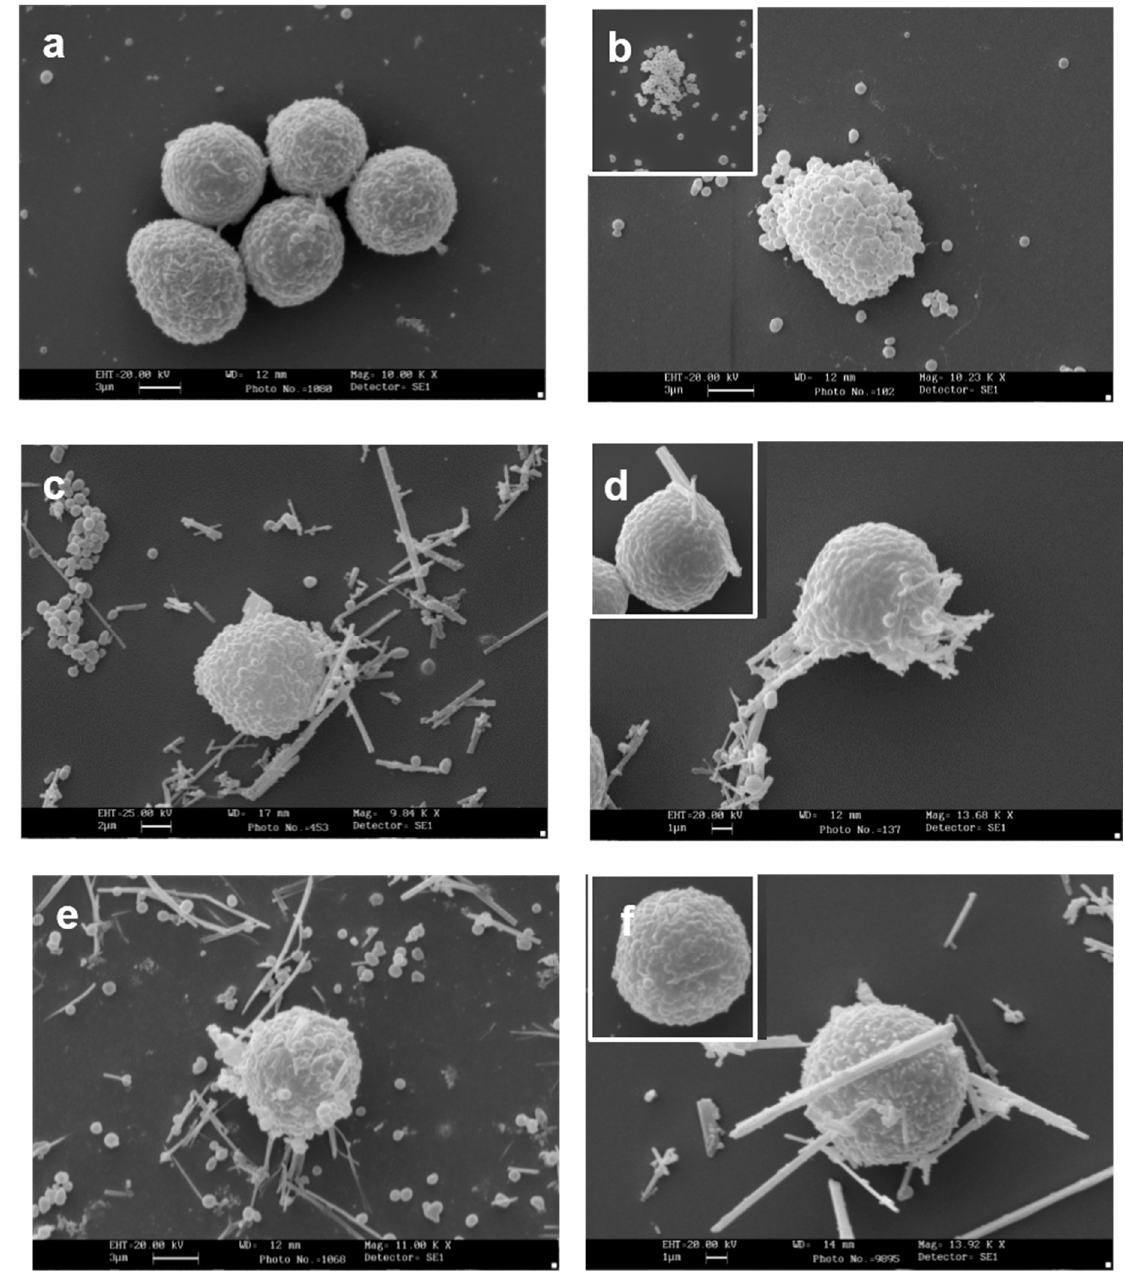
Figure 2. Scanning electron microscope appearance of RPMCs exposed to mineral fibers or stimulated with compound 48/80. ( a ) Unstimulated RPMCs after 30 min of incubation; ( b ) RPMCs exposed to 10 μ g/mL compound 48/80 for 30 min: a large number of granules are secreted and the cell surface shows many protruding granules, while the inset shows an RPMC ghost induced by 48/80; ( c , d ) RPMC exposed to 100 μ g/mL crocidolite for 30 min: an evident secretory response is shown, fiber-bound free granules as well as granule clusters can be seen, and numerous granule profiles protrude from the cell surface. (( d ) and inset) Asbestos fibers can be seen, entrapped by the RPMC; the fibers may have reached the cell interior by either penetration or frustrated phagocytosis; ( e ) an RPMC exposed to 100 μ g/mL TiO 2 NWs for 30 min. Note that numerous fibers interact with cell and free granules; (( f ) and inset) an RPMC exposed to 100 μ g/mL wollastonite fibers for 30 min. Note that despite many fibers being deposited on the RPMC surface there is no sign of degranulation. Magnification: bars in ( a , b , e ) = 3 μ m; bars in ( c ) = 2 μ m; in ( d , f ) = 1 μ m.